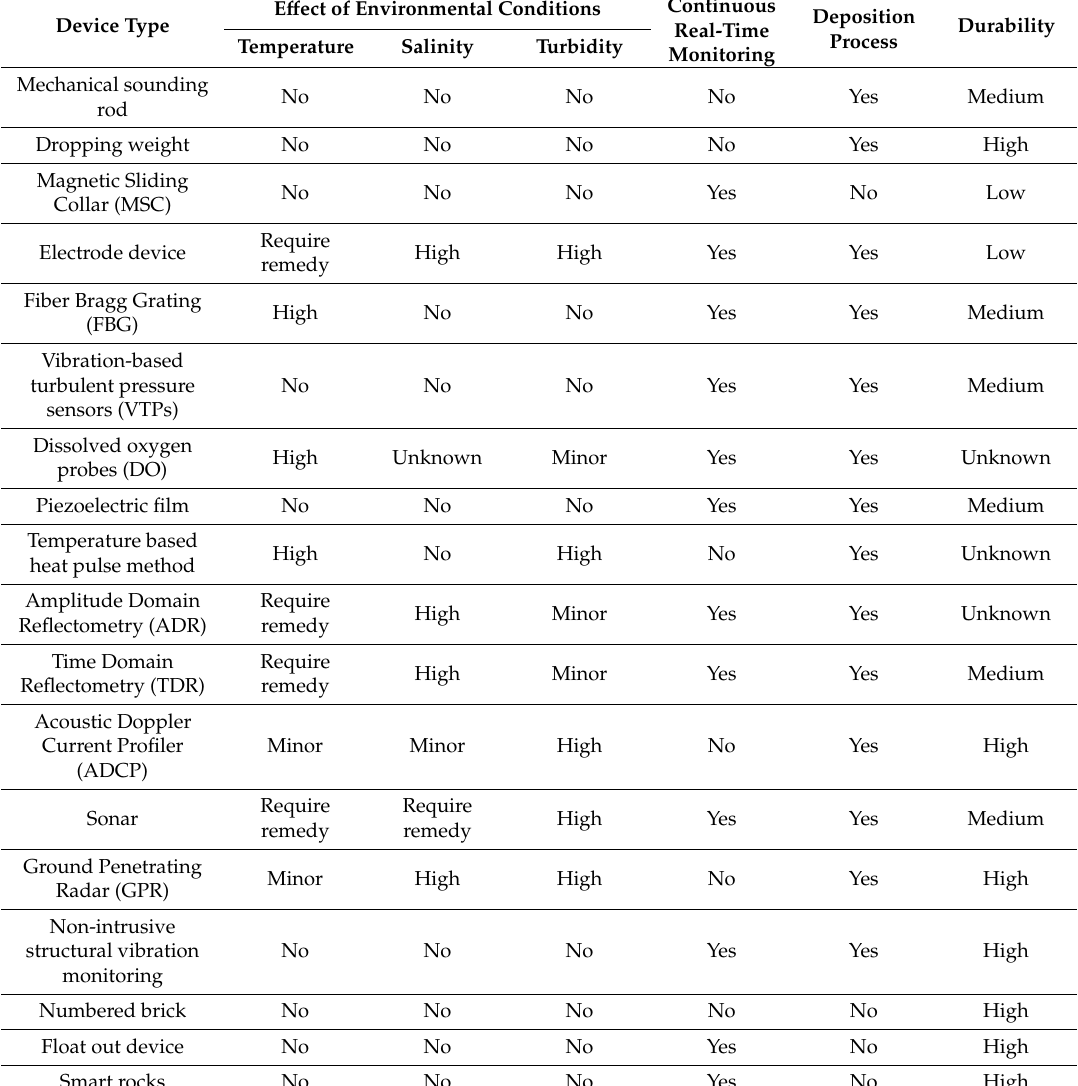
Table 1. Comparison of scour sensing techniques. (modified from